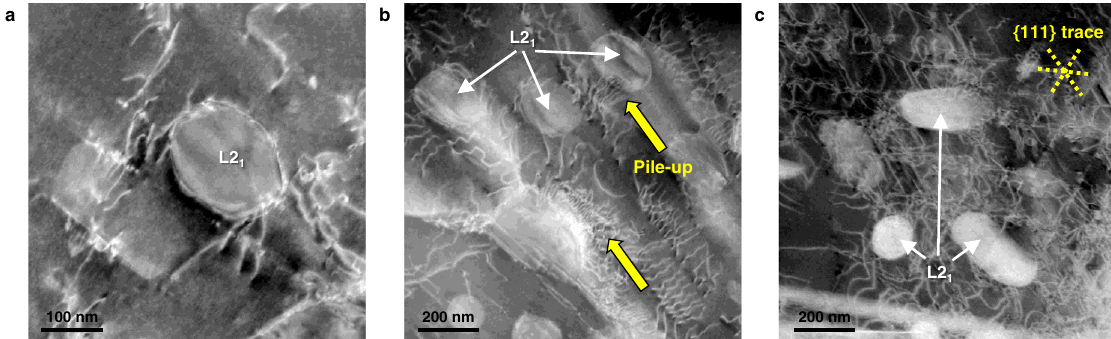
Fig. 5 High-angle annular dark- fi eld scanning transmission electron microscopy (HAADF-STEM) images showing deformation structures for the Al 0.2 VCoNi alloy annealed at 850 °C for 1 h. a Orowan bowing mechanism at a L2 1 precipitate interface. b Dislocations pile up ahead of the L2 1 precipitate. c Formation of planar-slip dislocation substructures along {111} plane traces and interactions with L2 1 precipitates. The deformation structures were observed for specimens deformed to ~1%